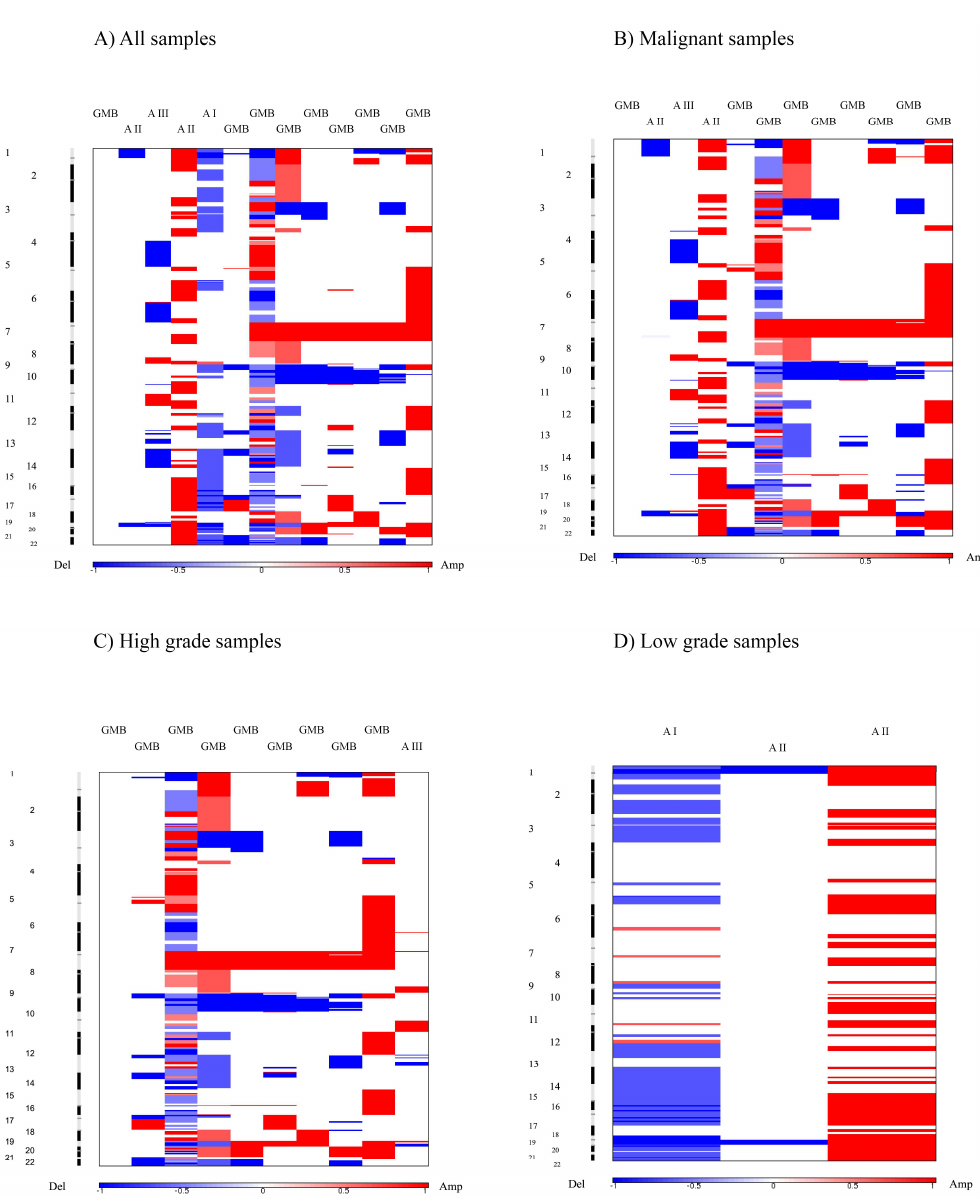
Figure 2. Heat map images of four different intracranial astrocytic brain tumor sample pools based on total segmented DNA copy number variation profiles. Images were analysed using GISTIC (v2.0.23). In each heat map, the samples are arranged from left to right, and chromosome arrangement flows vertical, top to bottom ordering. Red represents CN gain and blue represents CN loss. ( A ) all samples; ( B ) malignant samples; ( C ) high grade samples; ( D ) low grade samples.